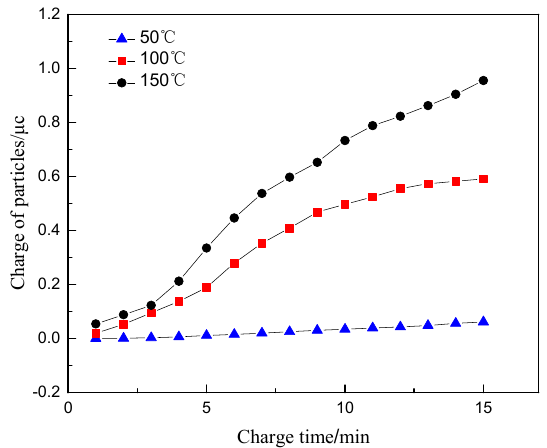
Figure 5. The relationship between the charge of particles and time at different temperatures.